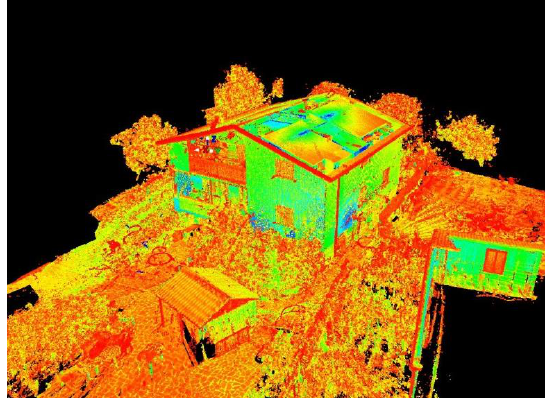
Figure 2. The total Point